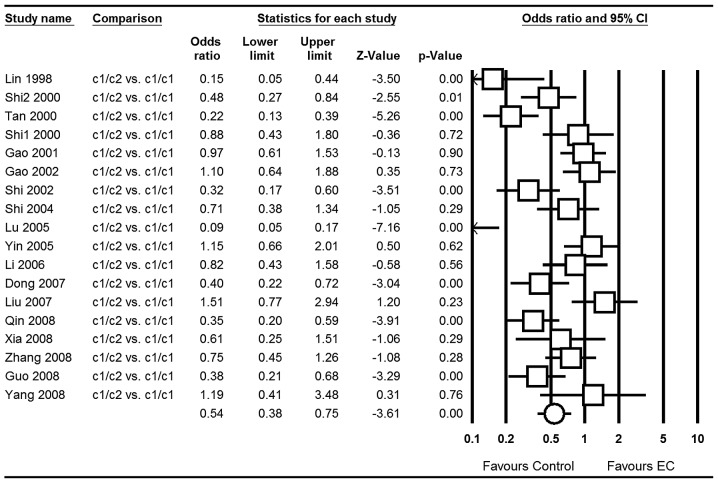
Forest plot of EC associated with CYP2E1 RsaI/PstI for the c1/c2 genotype compared with the c1/c1 genotype in total. CI, confidence interval; EC, esophageal cancer.